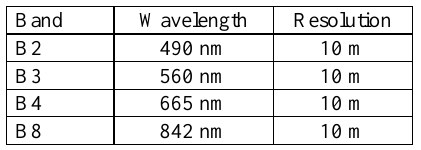
Table 1 . Sentinel-2 Bands chosen.